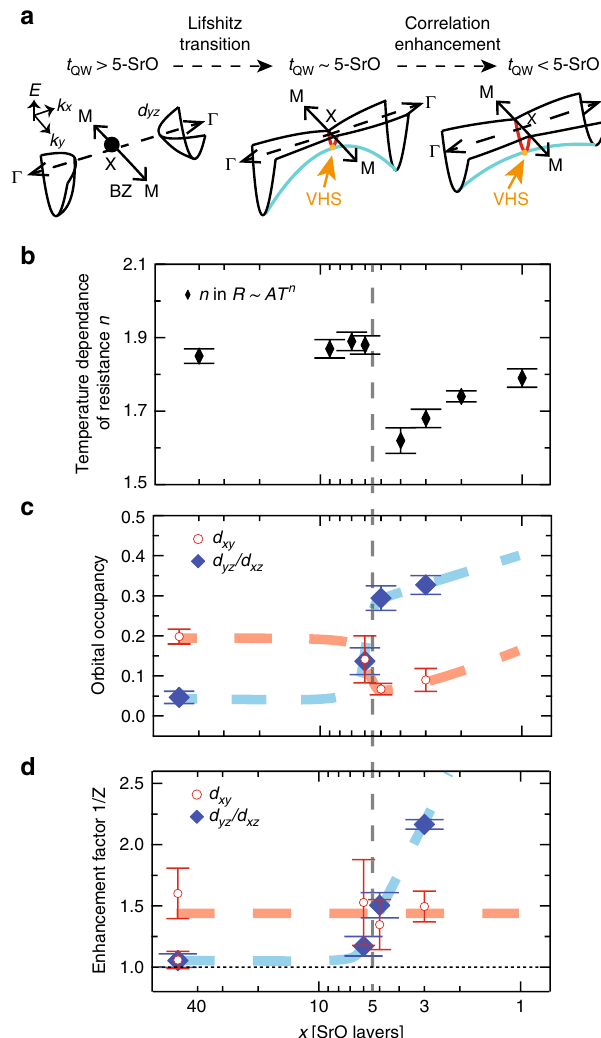
Fig. 4 Fermi surface topology and interlayer coupling a The schematics of Lifshitz transition and the effect of interlayer coupling as a function of t . QW The red and light-blue lines highlight the electron- and hole-like dispersion, respectively. After Lifshitz transition, the electron correlations in the quantum well are enhanced by the effect of interface – interface coupling, making the Van Hove singularity (VHS) deeper and the bandwidth around the Γ point shallower. b The temperature dependence of the resistance ( R (cid:2) AT n ) from the transport measurement in refs. 16 , showing the phase transition. c Evolution of orbital occupancy for orbital ( d xy (red circle) and d yz = xz (blue diamond) orbitals as a function of t . The total occupancy of the d yz = xz QW orbitals is twice of the value shown here, because of the degeneracy. d Electron mass enhancement factor 1 = Z for each orbital, d xy (red circle) and light d yz = xz (blue diamond) as a function of t . The red and blue dashed lines QW in c and d are guides to the eye for other thickness structures. The vertical black dashed line in b – d separates the two distinct phases of the system 15,16 . The error bars in c , d are estimated by absolute maximum variations of peak positions obtained by Lorentzian fi ttings for EDC and absence of strain relaxation/dislocations were con fi rmed by using transmission electron microscopy . The pseudocubic lattice parameter of SmTiO 3 is about 3.9 Å . The detail of the growth can be found in refs. 51,52 . To measure the interface directly, only two quasi-unit cells of top layer SmTiO 3 , which acts as the capping layer to both protect and create the interface states at once, are used. Photoemission measurement . ARPES measurements were performed at the Beamline 4.0.3 (MERLIN) of the Advanced Light Source in Berkeley, California.